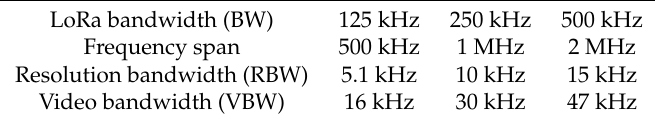
Table 7. Spectrum analyzer’s settings by specified LoRa bandwidth.